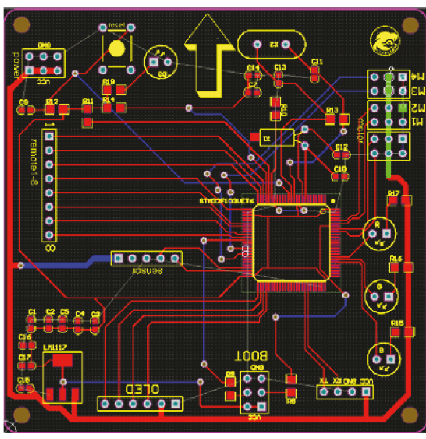
Figure 6: PCB wiring diagram. Figure 7: Flight control system fl ow chart.